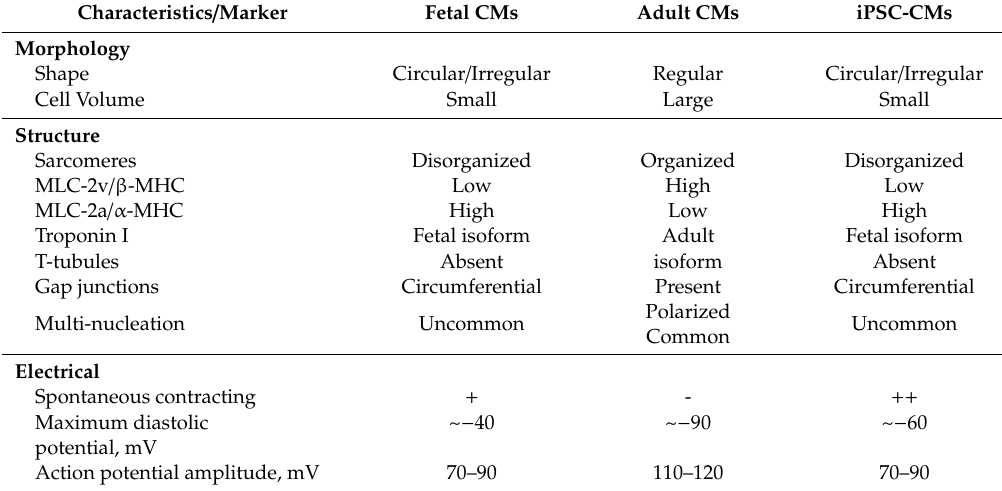
Table 1. Summary of the principal di ff erences between fetal, adult and induced pluripotent